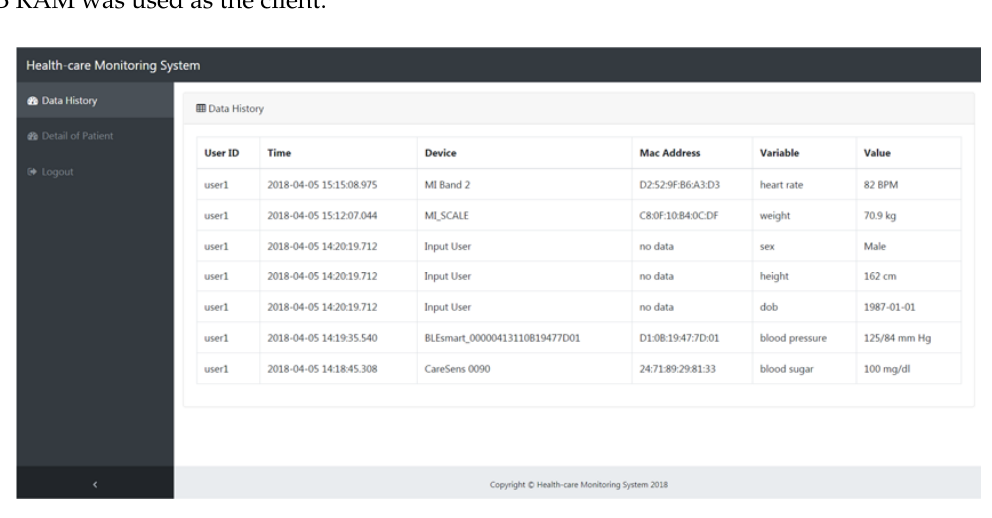
Figure 7. The web ‐ based personalized healthcare monitoring system. Figure 7. The web-based personalized healthcare monitoring